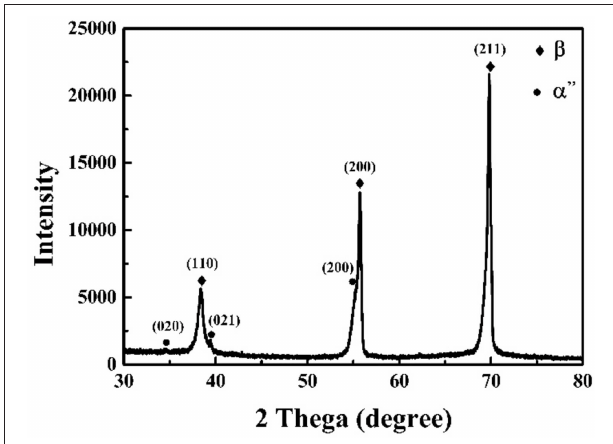
FIGURE 3 | XRD profile of the laser-quenched Ti-35Nb-2Ta-3Zr alloy.